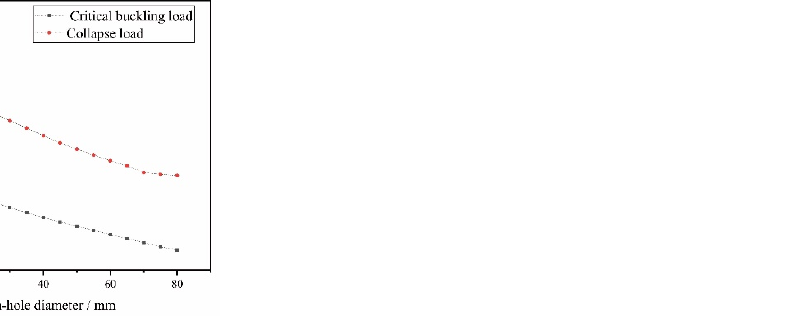
Figure 36. The first buckling mode of the FE models with the centered open-holes of different diam- eters.